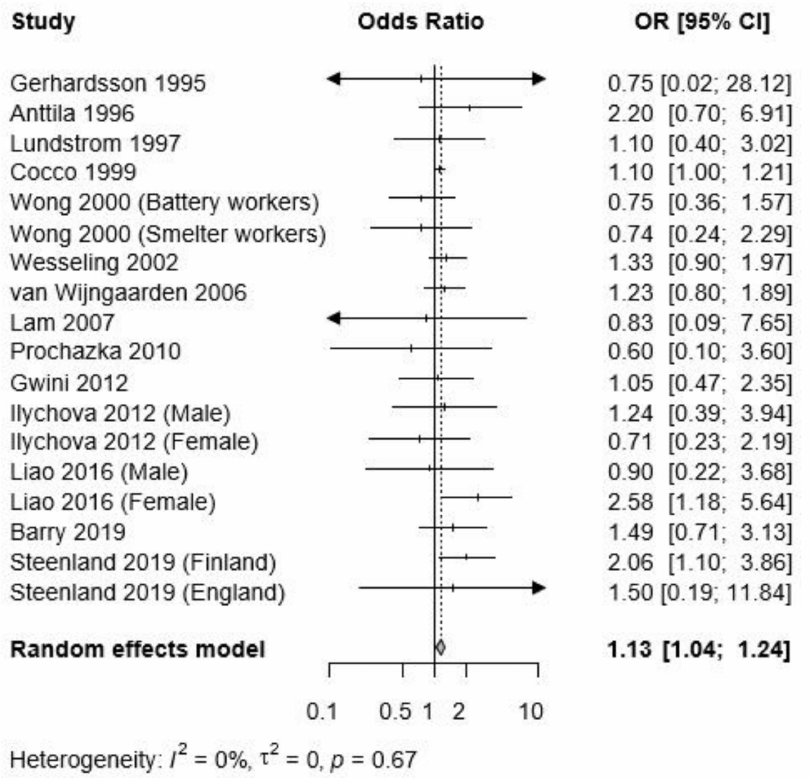
Figure 3. Forest plot of the risk estimates, log odds ratios (OR), and 95% confidence intervals (CI) from the studies included in the meta-analysis of the association between occupational lead exposure and malignant brain